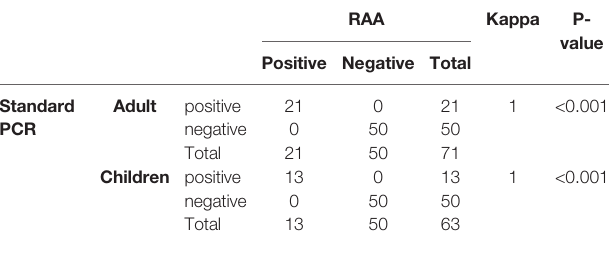
TABLE 1 | Detection of bla KPC in clinical specimens.